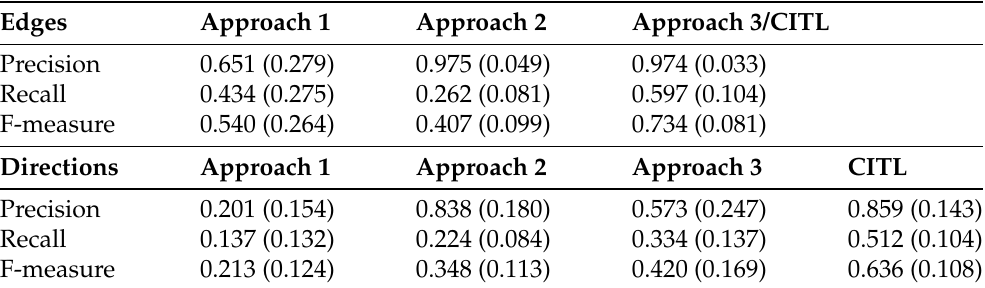
Table 1. Comparisons of different approaches based on